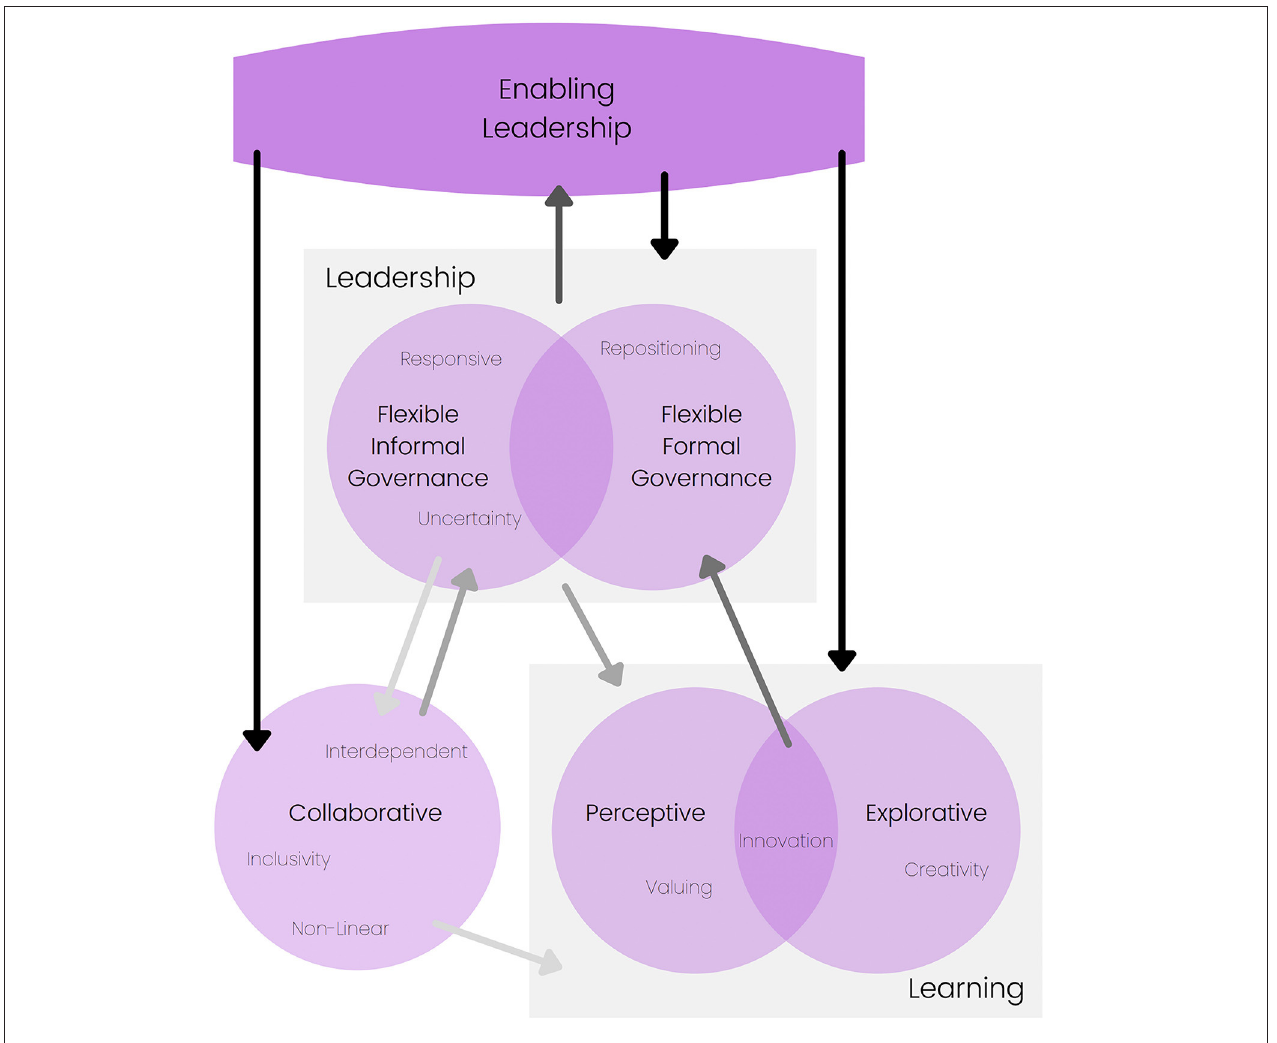
FIGURE 2 | Integrative Leadership Framework: Organizations face tension from stresses and shocks and must be able to respond quickly and effectively to the changing dynamics (i.e., enabling leadership). The purple circles represent emerging capabilities in leadership and organizational change literature, with the fine print words indicating characteristics of the capability. The darkening arrows indicate growing momentum toward a virtuous cycle, where all arrows would eventually be saturated. Notably, it is the efforts of integrating all the themes that enables conflict navigation and, ultimately,